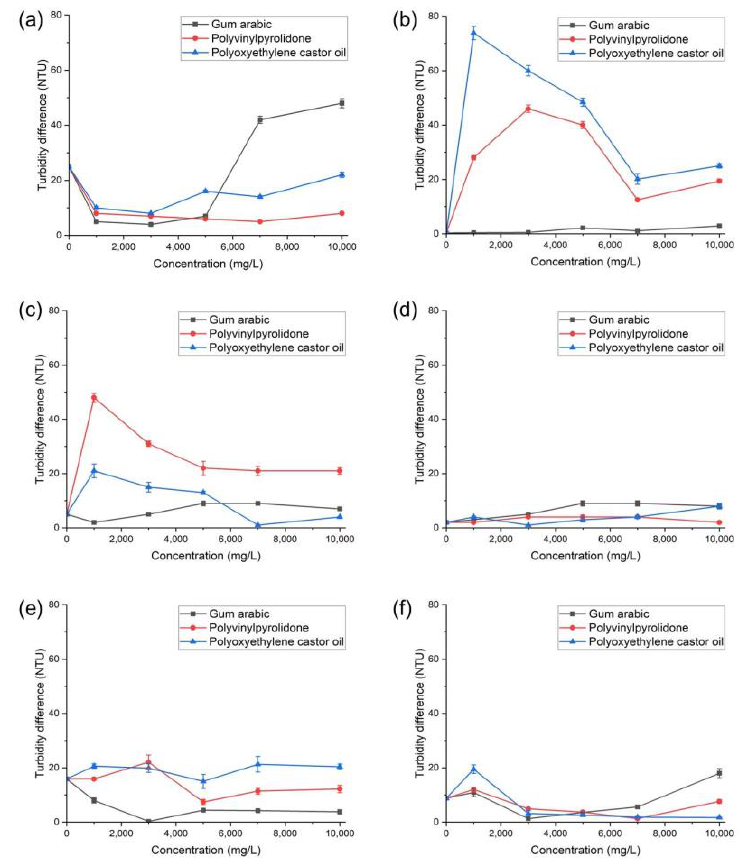
Figure 1. Turbidity difference values of manufactured nanomaterials by dispersant: ( a ) Al 2 O 3 , ( b ) carbon black, ( c ) nanoclays, ( d ): SiO 2 , ( e ) TiO 2 , and ( f ) ZnO.